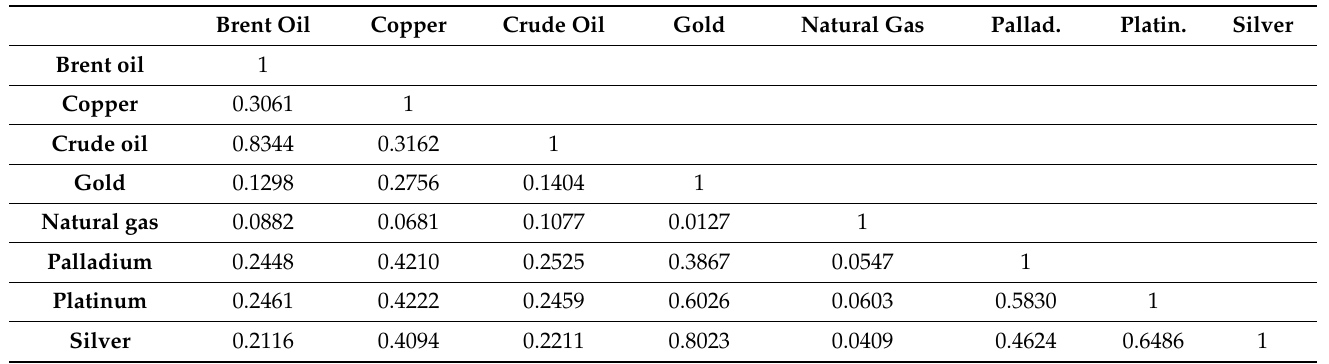
Table 9. Correlation between variables.